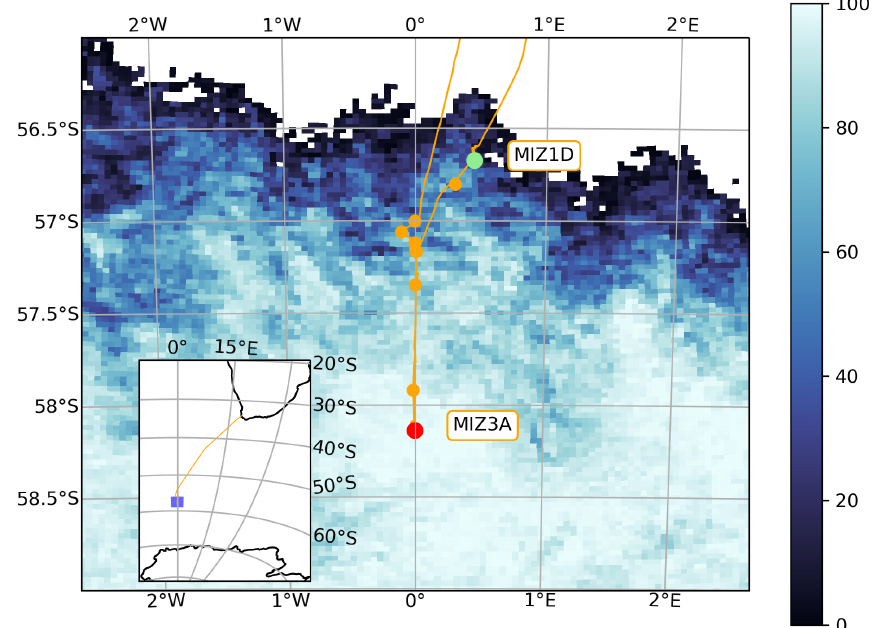
Figure 1. Map with the two ice stations MIZ1D and MIZ3A indicated by green- and red-coloured circles, respectively. The ship entered the MIZ from the westernmost course and exited from the easternmost course. The sea ice concentration chart was obtained from the University of Hamburg AMSR2 ASI processing for 26 July 2019, with concentration values in percent [%]. The small map inlet shows the route from Cape Town to the study area highlighted in blue colour.